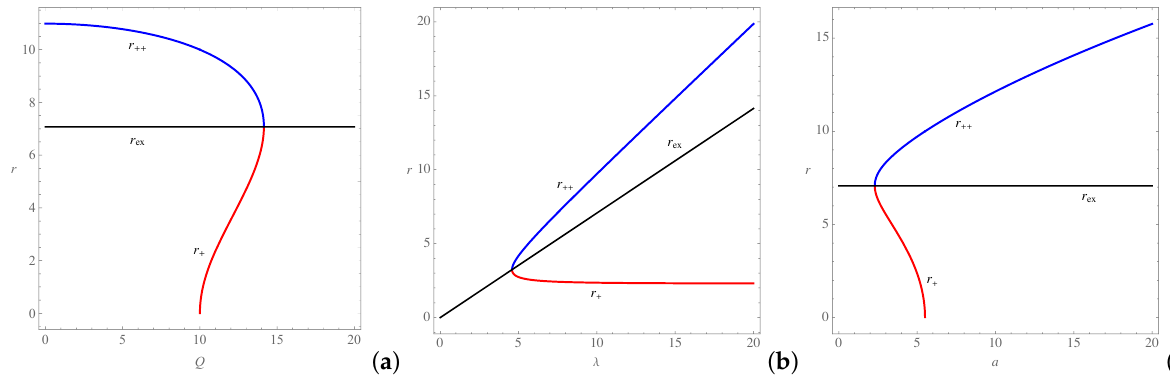
Figure 2. The behavior of the horizons of the RCWBH, plotted for ( a ) λ = 10 and a = 5, ( b ) Q = 11 and a = 5, and ( c ) λ = 10 and Q =